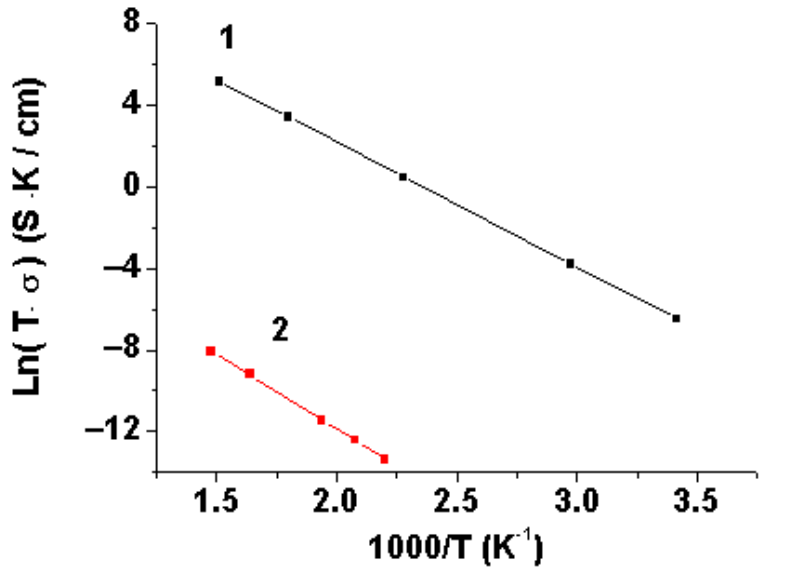
Figure 6. Total (1) and electronic (2) conductivity vs. reciprocal temperature for Li 3.8 Ge 0.9 S 0.1 O 4 solid electrolyte.